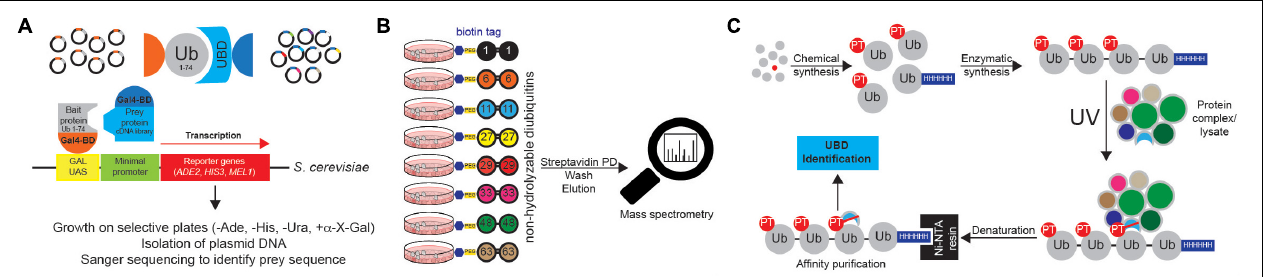
FIGURE 10 | Approaches to identify ubiquitin receptors. (A) A very common type of Y2H approach is based on the use of Ub sequence (lacking C-terminal Gly-Gly motif) as N-terminal fusion with the GAL4 binding domain (BD). The cDNA library containing putative UBDs consists of cDNAs cloned under the control of the lacZ promoter downstream of the DNA sequence encoding the activating domain (AD) of the yeast GAL4 transcription factor. Protein interaction induces the close proximity of GAL4AD and GAL4BD, forming the active transcription factor, which binds to the GAL1 upstream activating sequence (UAS) and activates